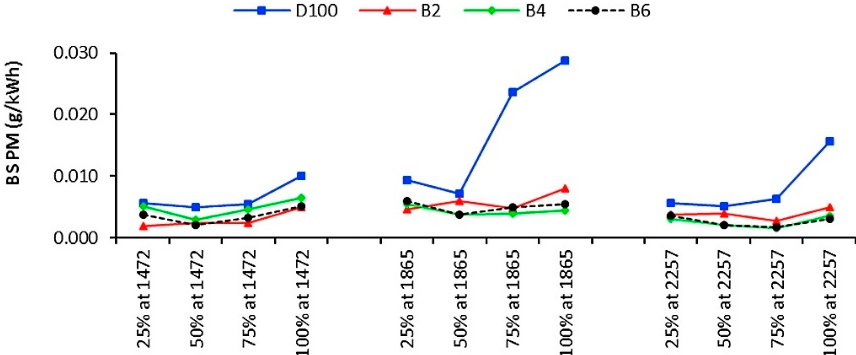
Figure 11. Particulate matter (PM) concentrations for all tested fuels under different speeds and loads [102].